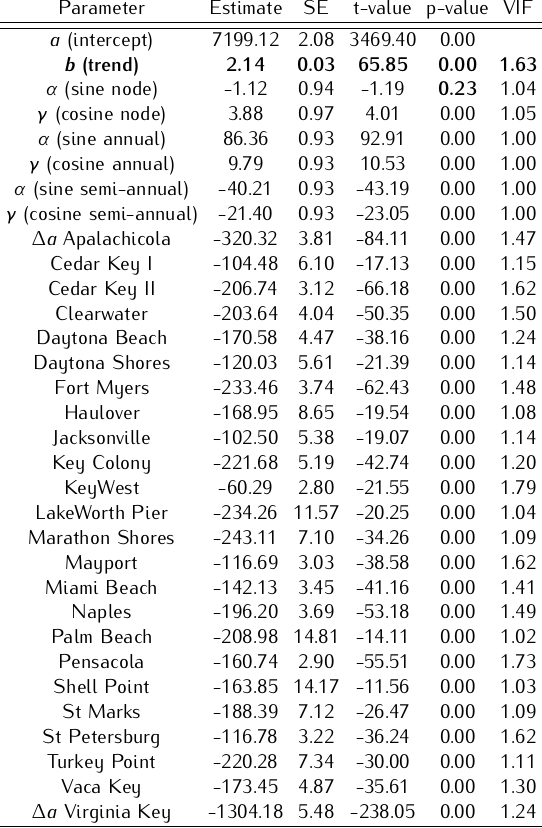
Table 5. Solution statistics for the regional model using ordinary least squares solution. Series time span: 112 years, RMS fit: 67.0 mm, and R 2 ( adj ): 87.7. The trend estimate and its standard error (SE) is in mm/yr. The other estimates and their standard errors are in mm. VIF is the variance inflation